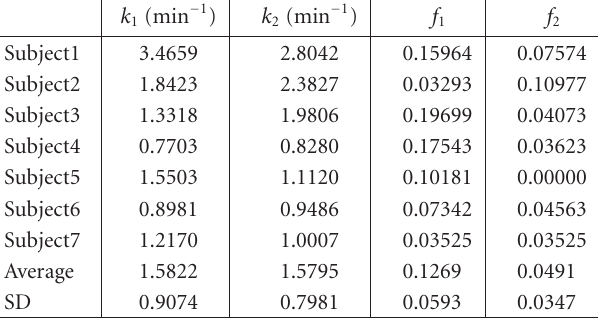
Table 1: Parameters of the kidney model.